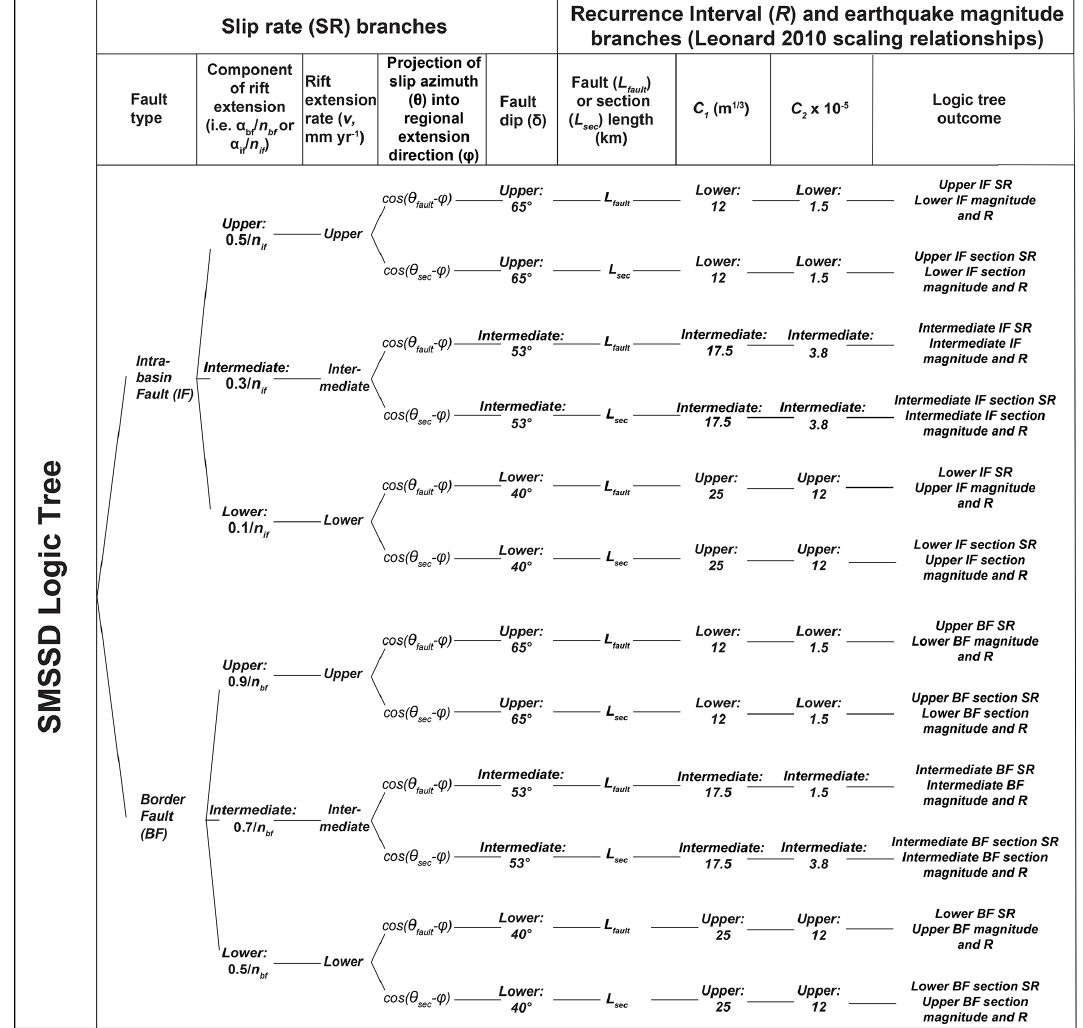
Figure 6. Logic tree for calculating lower, intermediate, and upper estimates of fault slip rates and earthquake magnitudes and recurrence intervals in the SMSSD; α bf and α if are the rift extension weighting assigned to border faults (BF) and intra-basin faults (IF) respectively; n bf and n if are the number of border or intra-basin faults in a basin respectively; and θ fault and θ sec are the respective whole-fault and individual-section slip azimuth